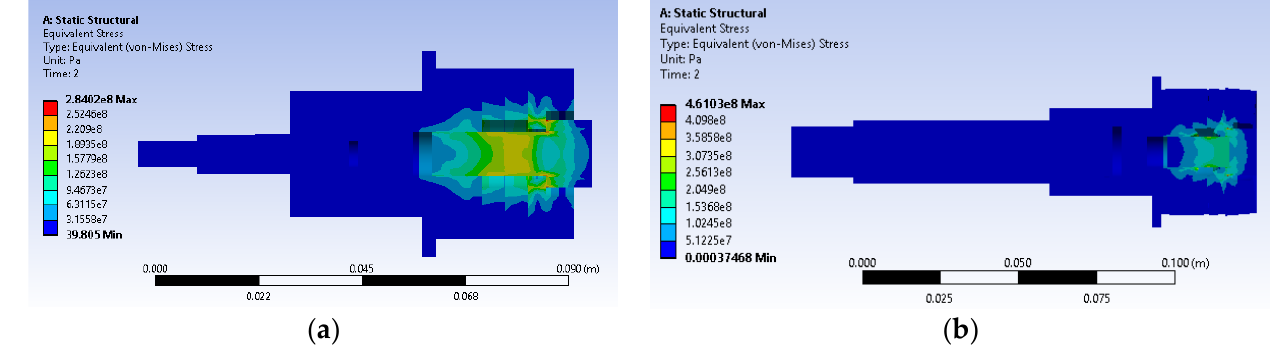
Figure 4. Equivalent stresses from FE static structure analysis for; ( a ) T1; and ( b ) T2.